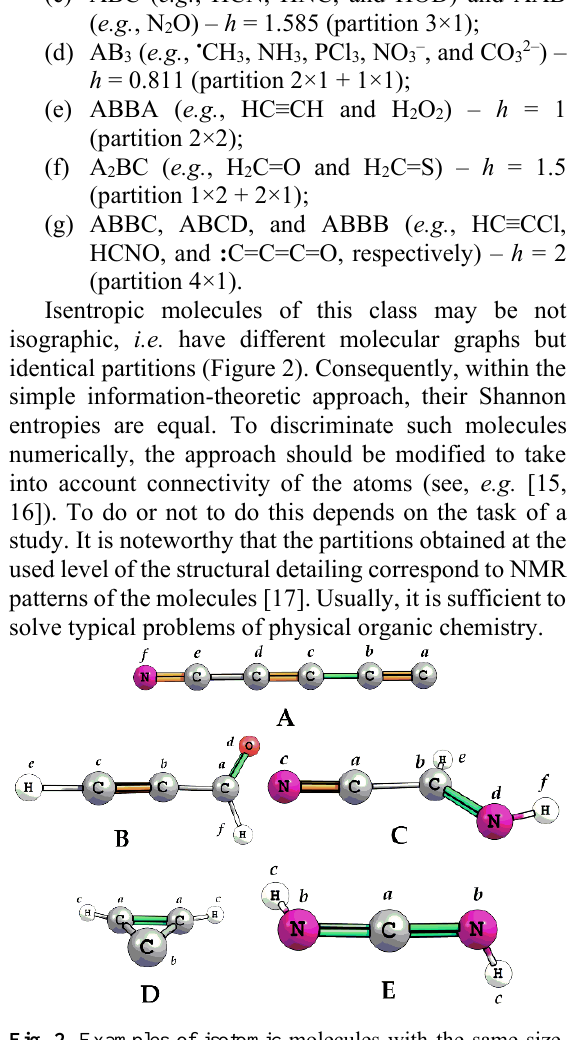
Fig. 2. Examples of isotomic molecules with the same size, partition pattern, and Shannon entropy but different molecular graphs. Molecules A – C consist of 6 atoms with partition 6×1 and h = 2.585 bits. Molecules D and E are penta-atomic with partition 2×2 + 1×1 and h = 1.522 bits. Names of the molecules: cyanobuthadiynyl radical ( A ), propynal ( B ), E - cyanomethanimine ( C ), cyclopropenylidene ( D ), and carbodiimide ( E ). Inequivalent atoms in the molecules are